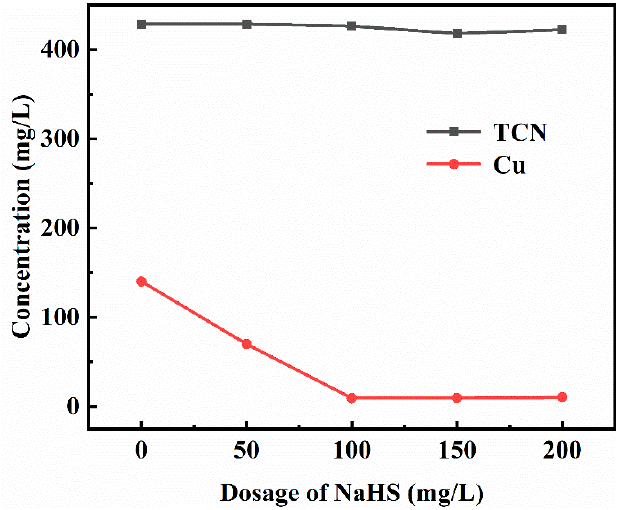
Figure 8. Effect of sodium hydrosulfide dosage on the copper precipitation effect. Table 3. Chemical composition of copper products.